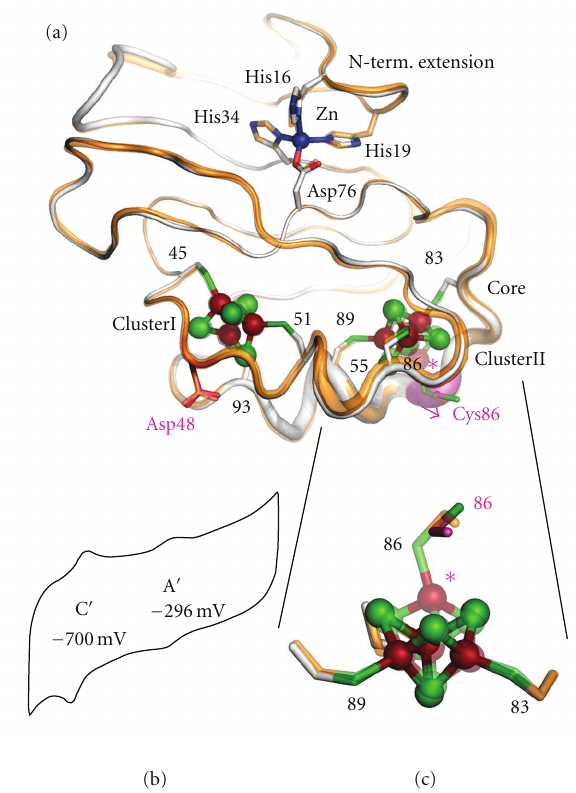
Figure 1: Comparative structures by superposition of archaeal zinc-containing ferredoxins from S. tokodaii (6Fe form, mostly gray, and pink for Asp48 and Cys86; 1xer.pdb [47, 48]) and A. ambivalens (7Fe form, transparent orange; 2vkr.pdb [49]), drawn in B -factor putty mode with PyMOL < http://pymol.sourceforge.net/ > (a), and their close-up view by superposition of the cluster II site (c). In panels (a) and (c), key residues are labeled; pink asterisk indicates the special iron of the cluster II, which is missing in the 6Fe form (1xer.pdb). Typical fast-scan film voltammogram (at 400mV · s − 1 ) of the 6Fe form of zinc-containing ferredoxin purified from S. tokodaii [17, 44] (measured with a pyrolytic graphite “edge” (PGE) electrode in 5mM each of MES/PIPES/HEPES bu ff er, pH 7.0, containing 100mM NaCl and 0.2 mg/ml poly-L-lysine (Sigma) as a protomer [16]; Couple A (cid:3) (for [3Fe-4S] 1+ / 0 ), E 1 / 2 = − 296 mV (versus NHE); Couple C (cid:3) (for [3Fe-4S] 0 / 2 − ), E − 700 mV (versus NHE); note that wave couple B for [4Fe-4S] 2+ / 1+ ( E 1 / 2 = − 530 mV versus NHE) [16] was undetectable in the cyclic voltammogram) [T.I. and K. Tanaka, unpublished results]